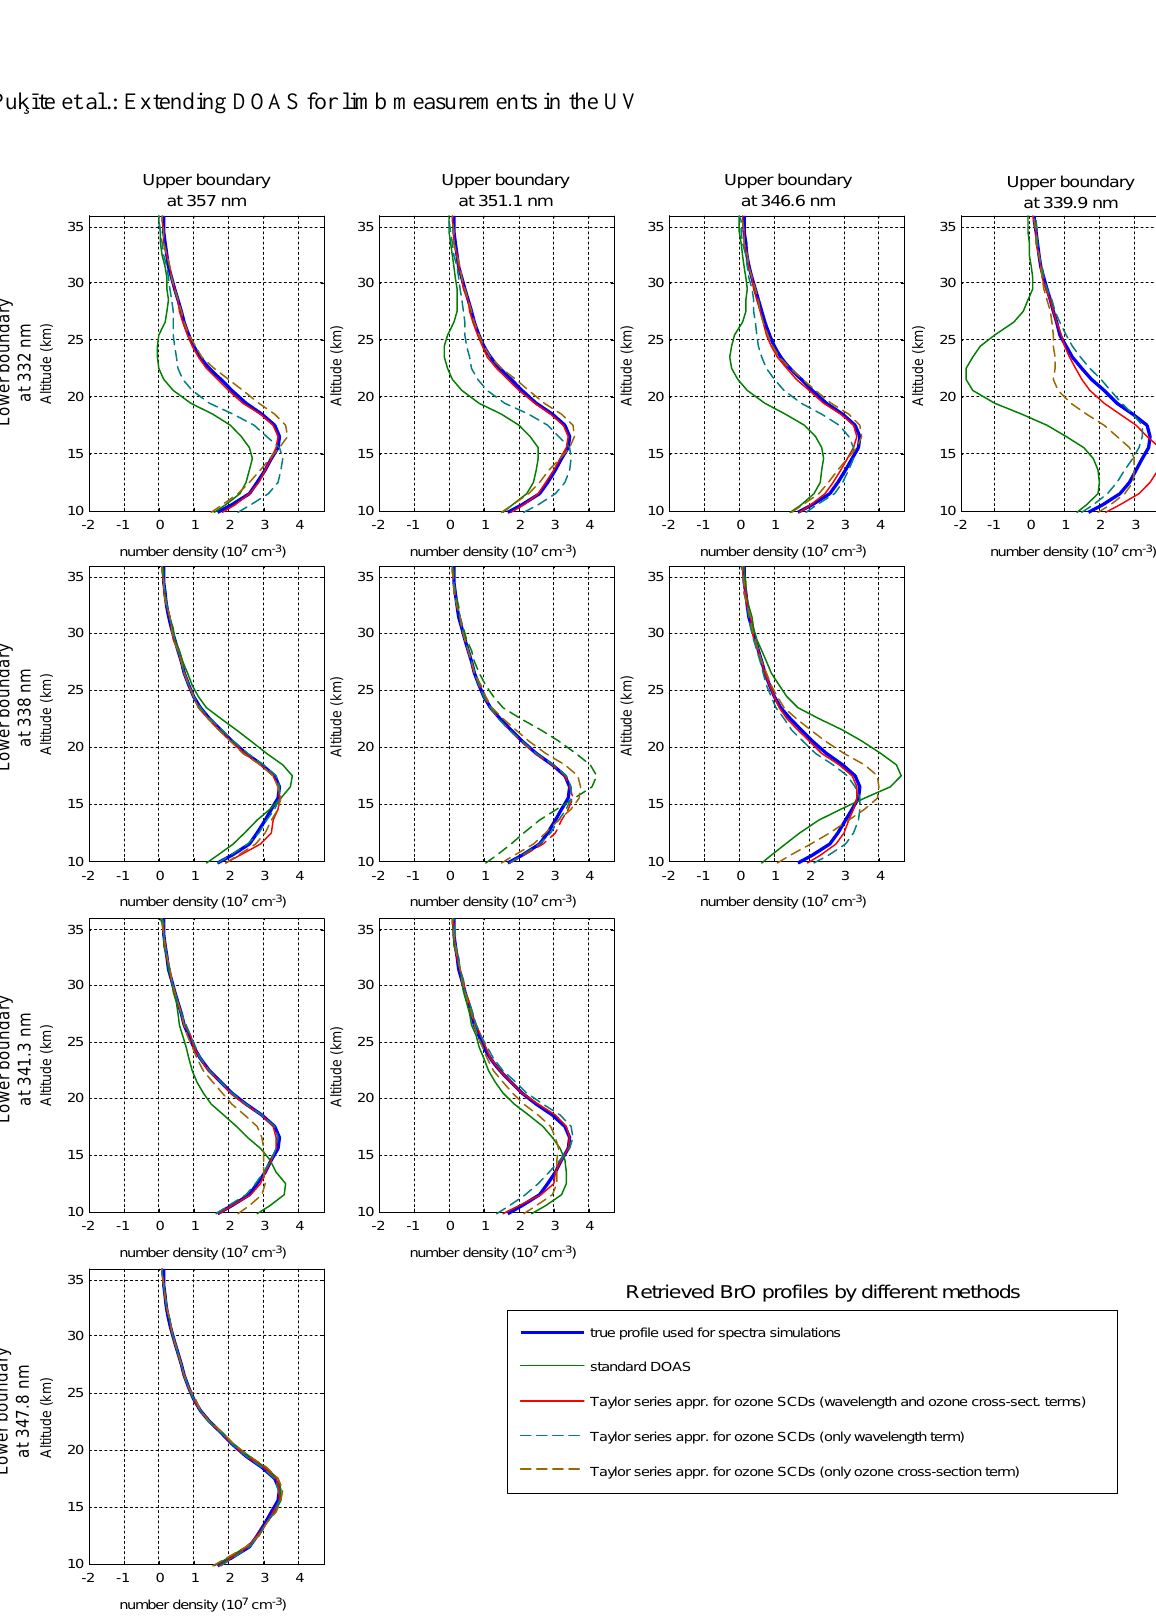
Fig. 7. Vertical profiles of the BrO number density retrieved from the simulated spectra for different fit windows and different retrieval approaches. Plots in the same row correspond to the same lower boundary of the fit window, plots in the same column to the same upper boundary of the fit